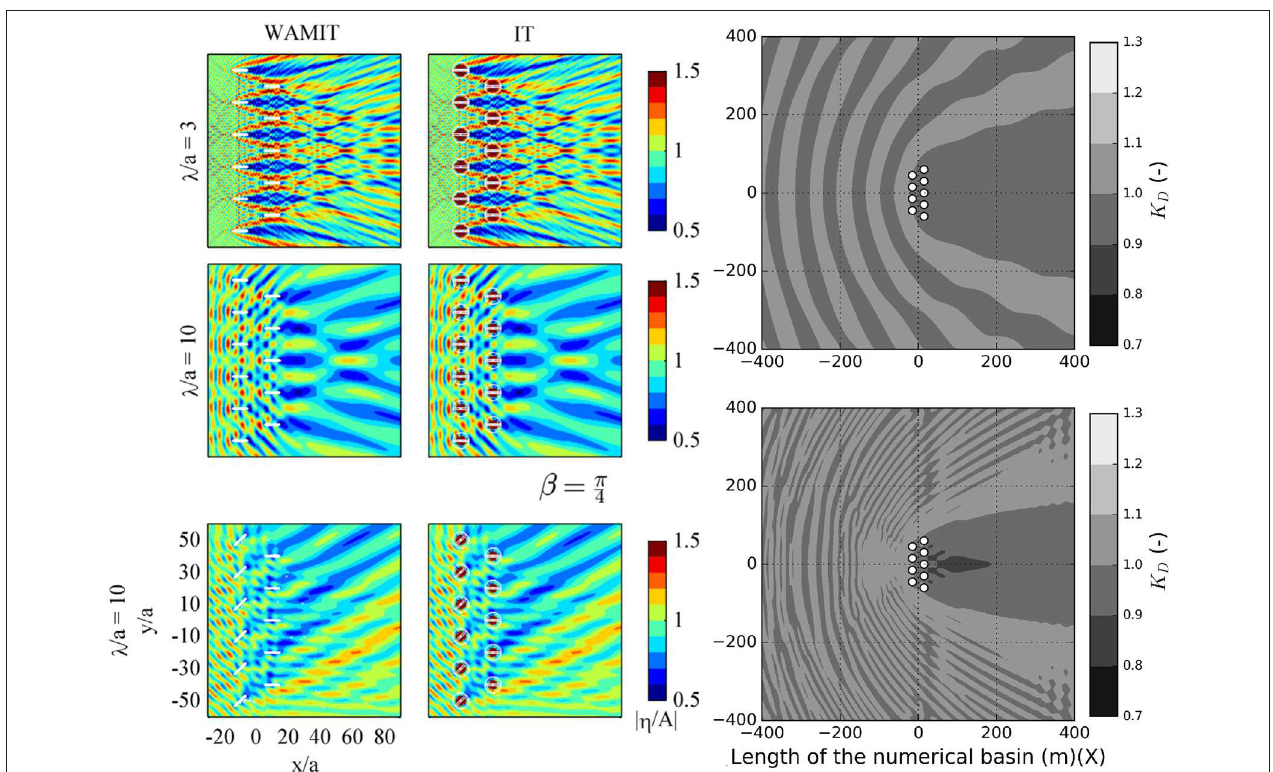
FIGURE 1 | (Left) The analytical multiple-scattering method was extended by McNatt et al. (2015) to allow for arbitrary geometry and used to study array interactions of attenuator WECs. The figure shows wave fields produced with the BEM software WAMIT and the analytical method (denoted IT in the figure). (Right) Wave propagation in a nine-WEC array in regular (top) and irregular (bottom) waves computed using NEMOH ( Verao Fernández et al., 2018).